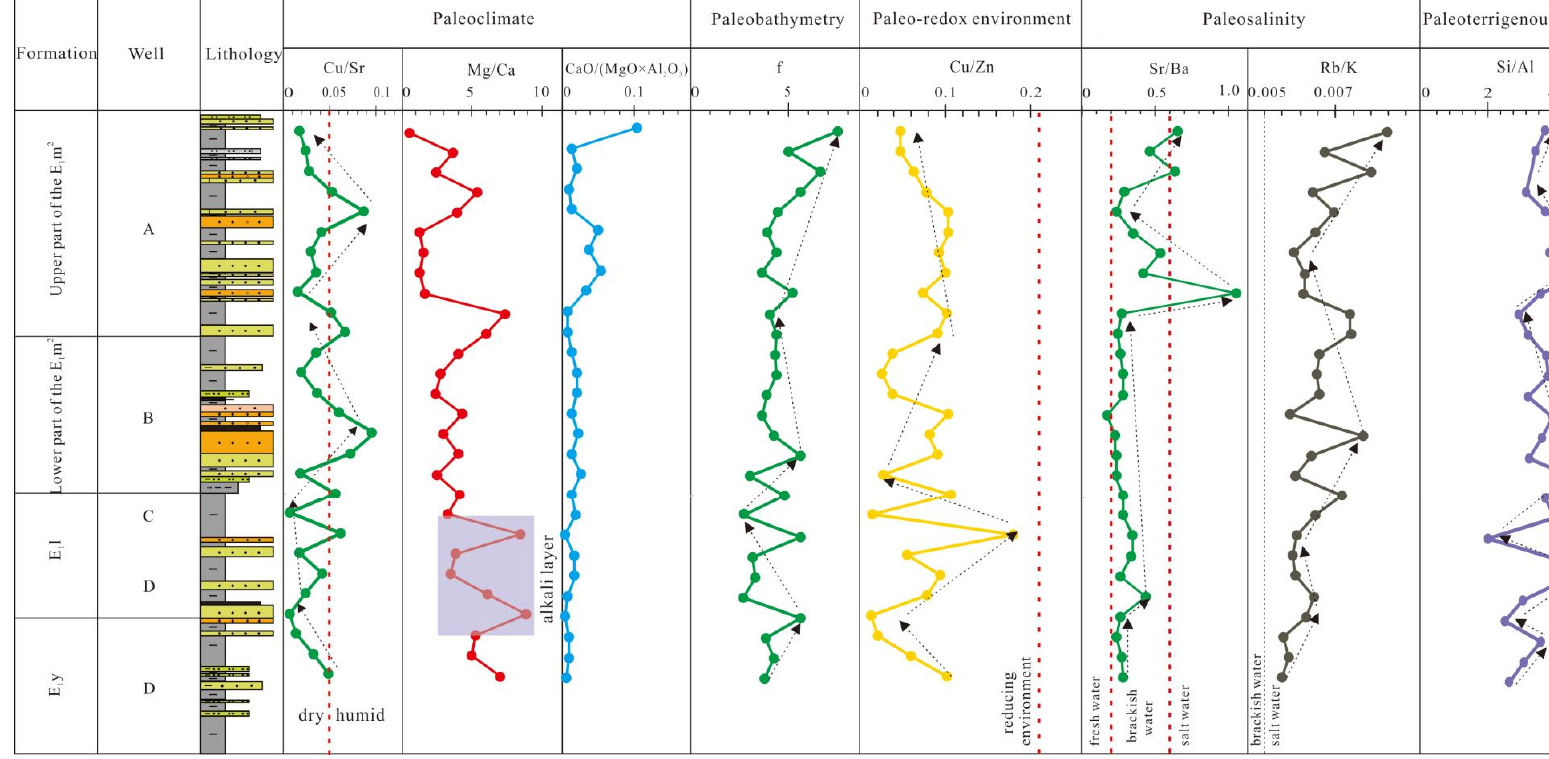
Figure 21. The paleoenvironment and paleoproductivity evolution of the Paleocene in the West Lishui Sag.